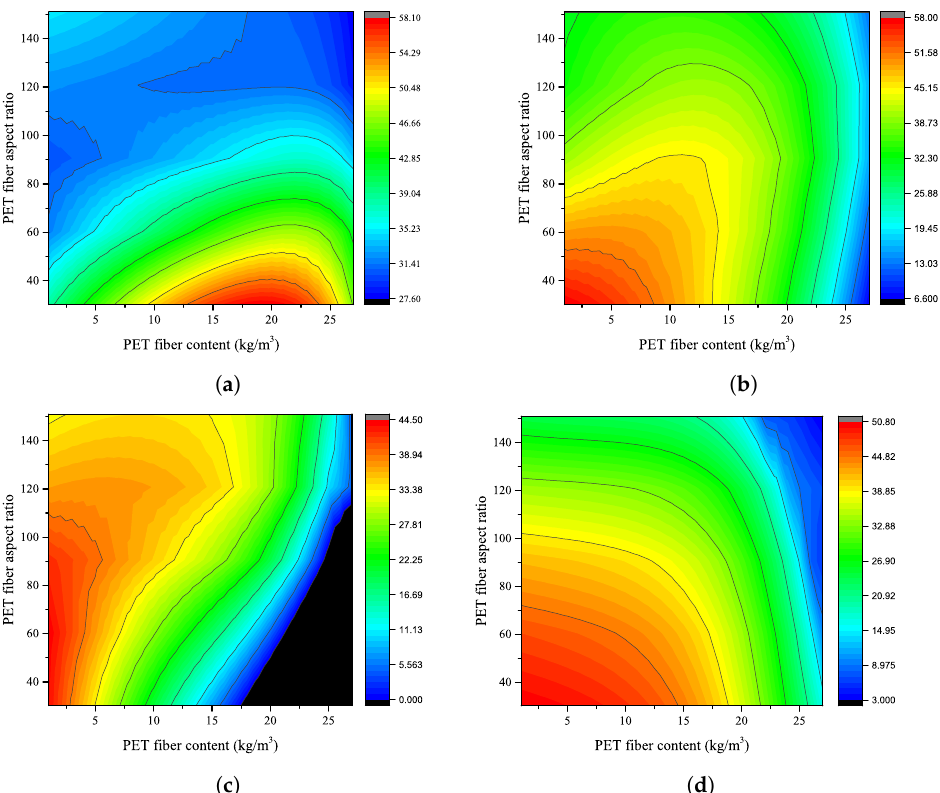
Figure 6. The variation of the 28-day compressive strength for different PET fiber content, as- pect ratios, and fiber shapes. ( a ) String shape, ( b ) Irregular shape, ( c ) Deformed shape, and ( d ) Embossed